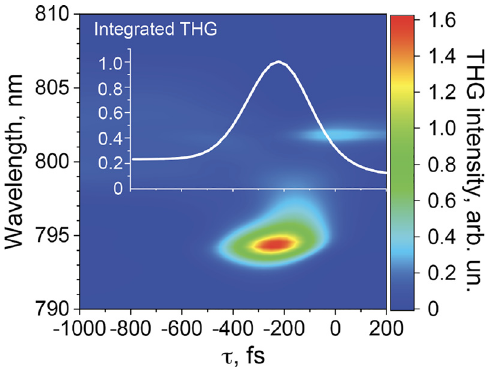
Figure 4: Spectrum of the THG in the metasurface obtained from a dynamic FDTD model plotted versus the delay between the control and excitation 𝜏 . The inset plot shows the total spectrally integrated THG generated in the metasurface as a function of 𝜏 .